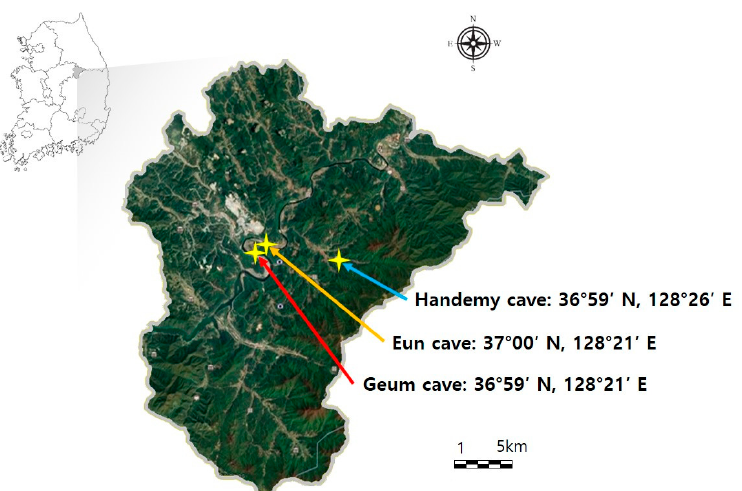
Figure 1. Map of the sample collection sites for this study. The picture is a magnification of the gray area of the South Korean map, and the location of the three caves within Danyang is marked with yellow crosses. The environmental samples, bat skin swabs, and oral swabs samples were collected from each site.